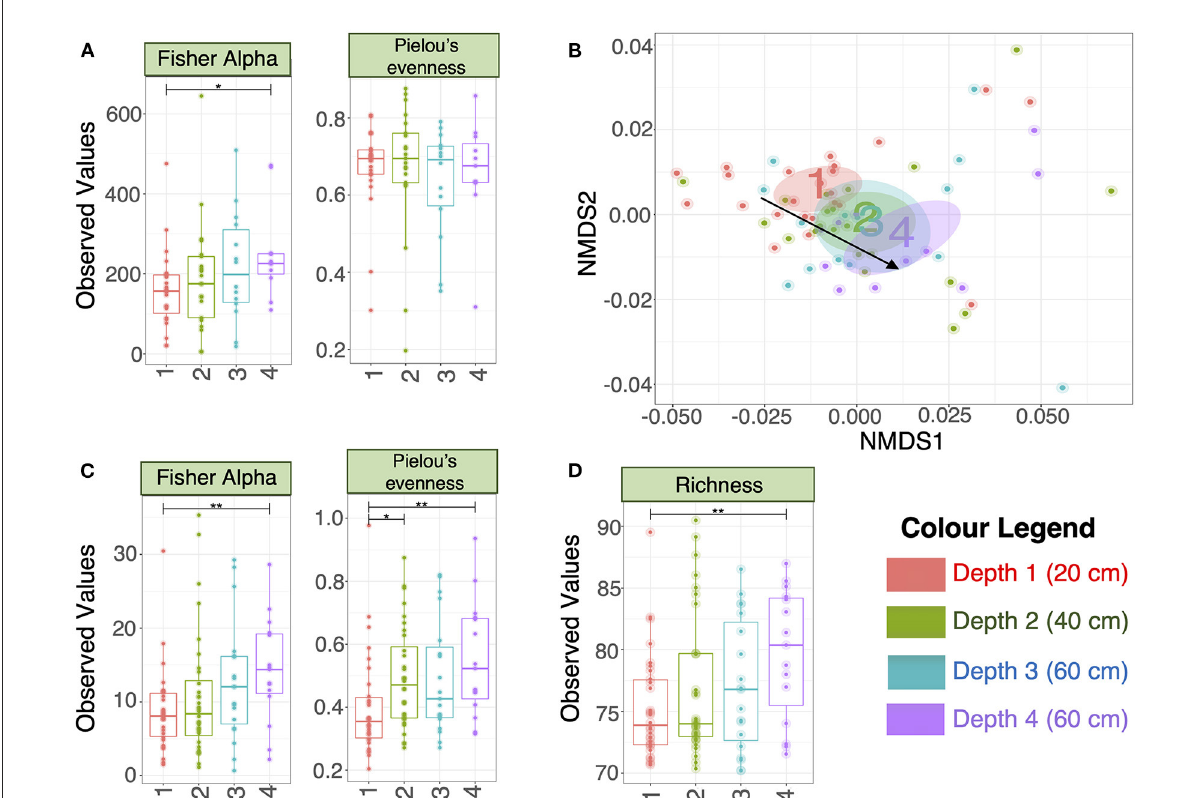
FIGURE2 (A) Alpha diversity metrics calculated on the rarefied microbiota data (OTUs at 3% divergence) from the four different pit latrine sample depths (Depth 1 = 20cm, Depth 2 = 40cm, Depth 3 = 60cm, and Depth 4 = 80cm); (B) Nonmetric multidimensional distance scaling (NMDS) plot (beta diversity) using weighted Unifrac distance. The ellipses represent the 95% confidence interval of the standard error of the ordination points of a given category (Depth 1 = 20cm, Depth 2 = 40cm, Depth 3 = 60cm, and Depth 4 = 80cm) and the labels are drawn at the mean value of the ordination points; (C) Alpha diversity metrics calculated on the rarefied EnvO table returned from seqenv pipeline, indicating that the diversity of defined “descriptors” increased with increasing pit sample depth (Depth 1 = 20cm, Depth 2 = 40cm, Depth 3 = 60cm, and Depth 4 = 80cm); (D) Richness was calculated as the exponential of Shannon entropy on the proportional representation of 284 KEGG pathways returned from Tax4Fun software. Depth 1 = 20cm, Depth 2 = 40cm, Depth 3 = 60cm, and Depth 4 = 80cm. For (A,C,D) , we performed pair-wise ANOVA, taking two pit latrine sampling depths at a time. Significance values were indicated as follows (*0.01 ≤ p < 0.05; **0.05 ≤ p < 0.001. Other alpha-diversity measures (Richness, Shannon and Simpson) are shown in Supplementary Figure